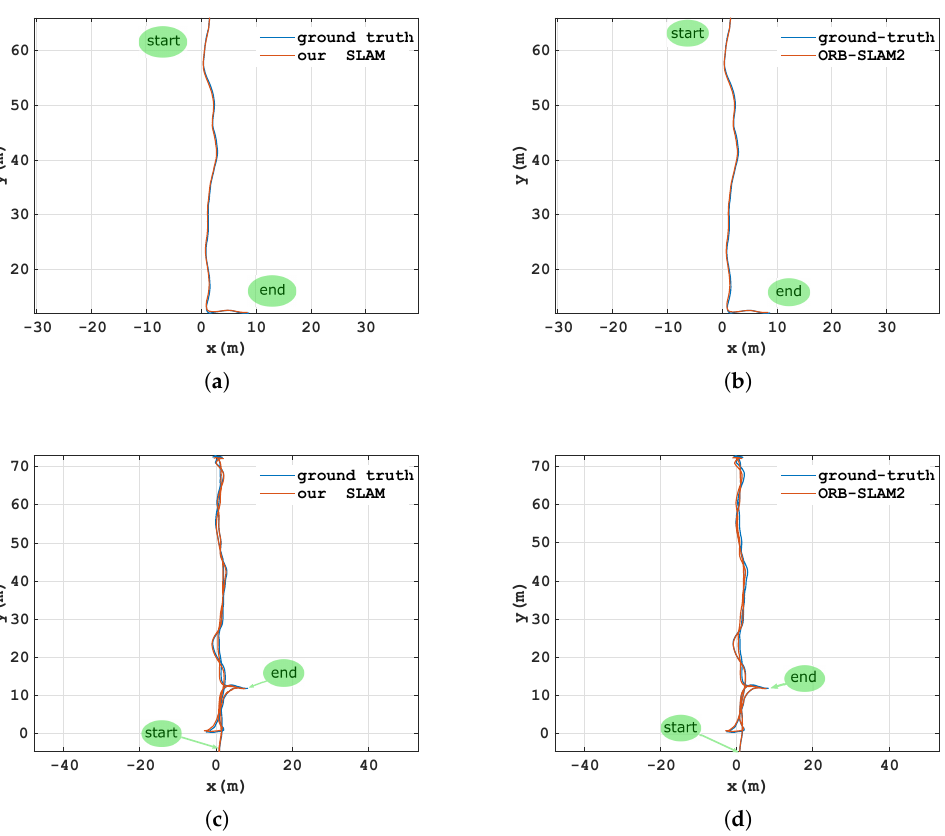
Figure 10. Accuracy performance of our method and ORB-SLAM2 for different sequences using a laser sensor as the ground truth. ( a ) Ours-a. ( b ) ORB-SLAM2-a. ( c ) Ours-b. ( d ) ORB-SLAM2-b.